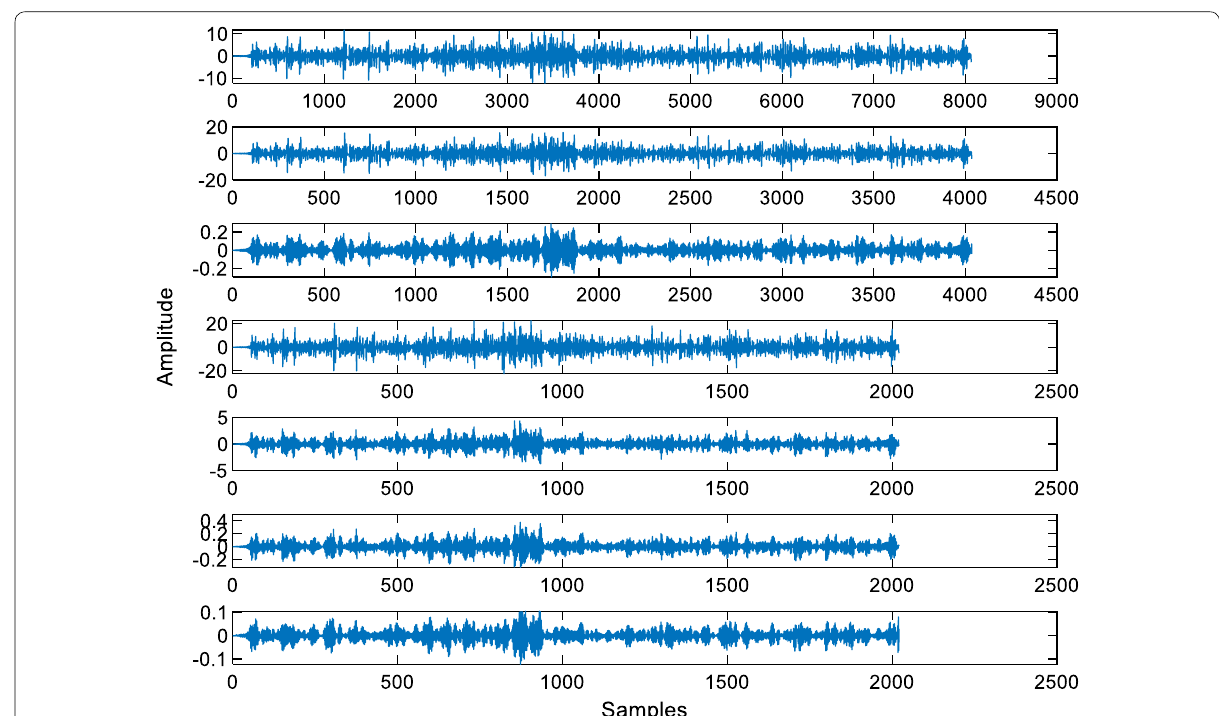
Fig. 3 The wavelet packet decomposition of an EEG signal. 2 level decomposition is used using the Daubechies wavelet of order 4